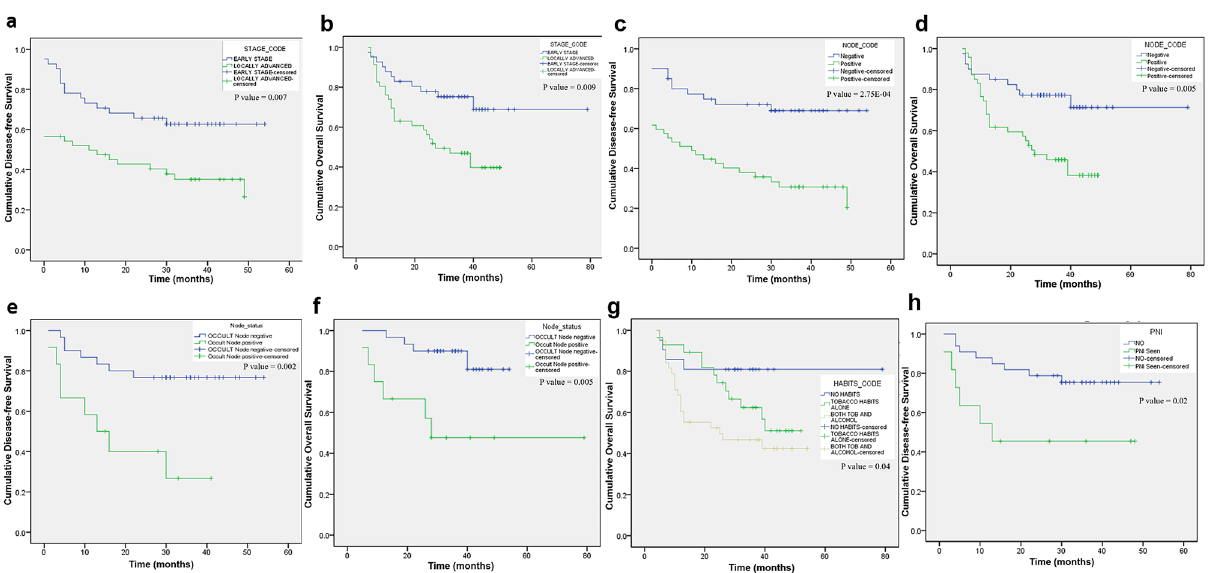
Figure 6. Kaplan–Meier survival analysis of clinicopathological variables in OTSCC patients ( a ). Disease free survival by clinical stage ( b ). Overall survival by clinical stage ( c ). Disease free survival by neck node status ( d ). Overall survival by neck node status ( e ). Disease free survival by occult node status ( f ). Overall survival by occult node status ( g ). Overall survival by habits status ( h ). Disease free survival by Perineural invasion in early stage OTSCC treated by surgery. P values correspond to the log-rank test comparing the survival